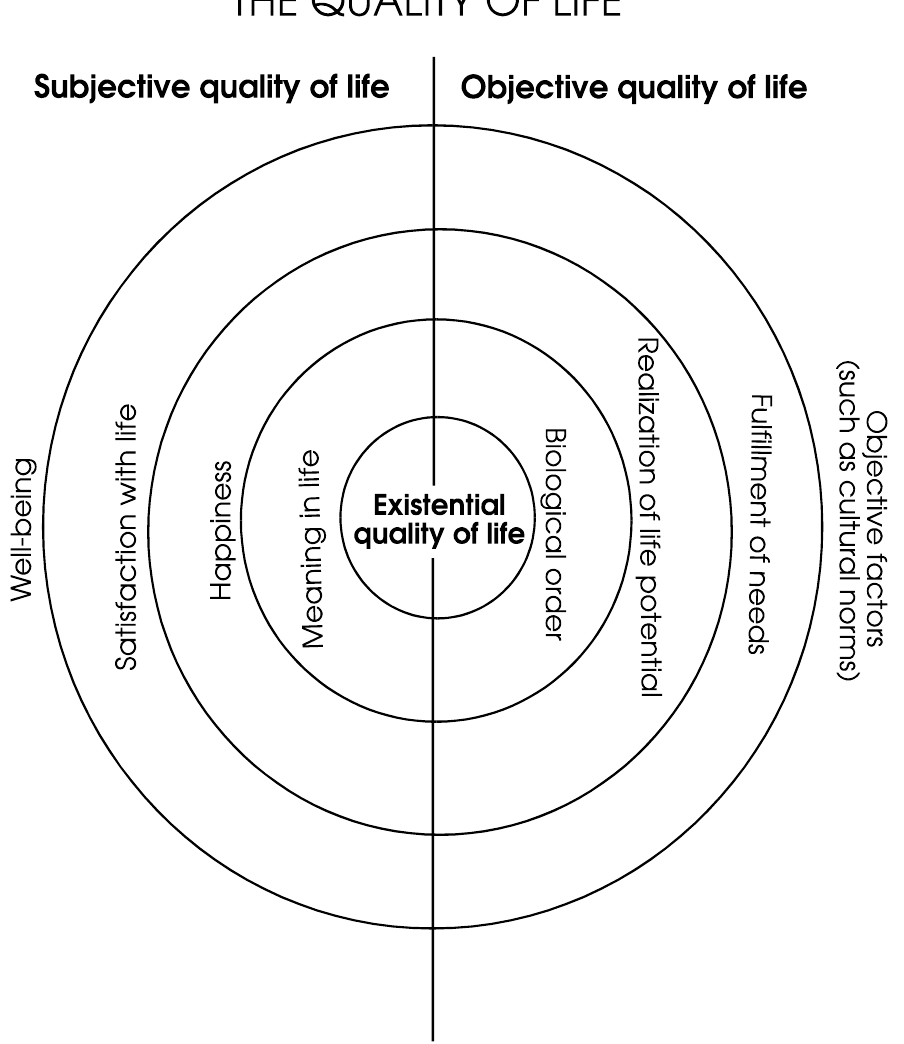
FIGURE 1. The integrative theory of the quality of life. The individual can best be compared to a green apple with red patches (a subjective and an objective quality of life, respectively, at the surface of an individual’s existence) with a hidden nucleus (humanity’s inner depth). When this picture is combined with the picture of humanity as an onion with a number of layers between the surface and the nucleus, the taxonomy underlying the quality-of-life analysis is achieved. Between life’s surface and its inexpressible depth lie well being, satisfaction, harmony, and meaning and deep